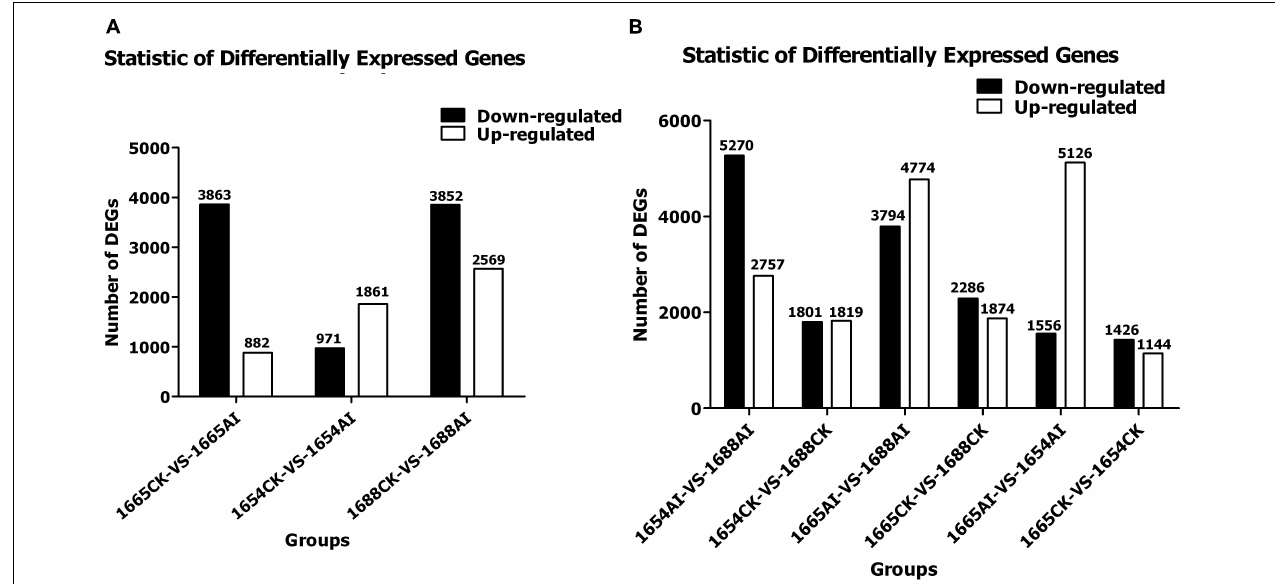
FIGURE 1 | Statistics of differentially-expressed genes in three rice cultivars after SSB artificial infestation compared with the non-infested control: (A) within; and (B) between cultivars. (AI) artificial infestation; (CK) non-infested control.